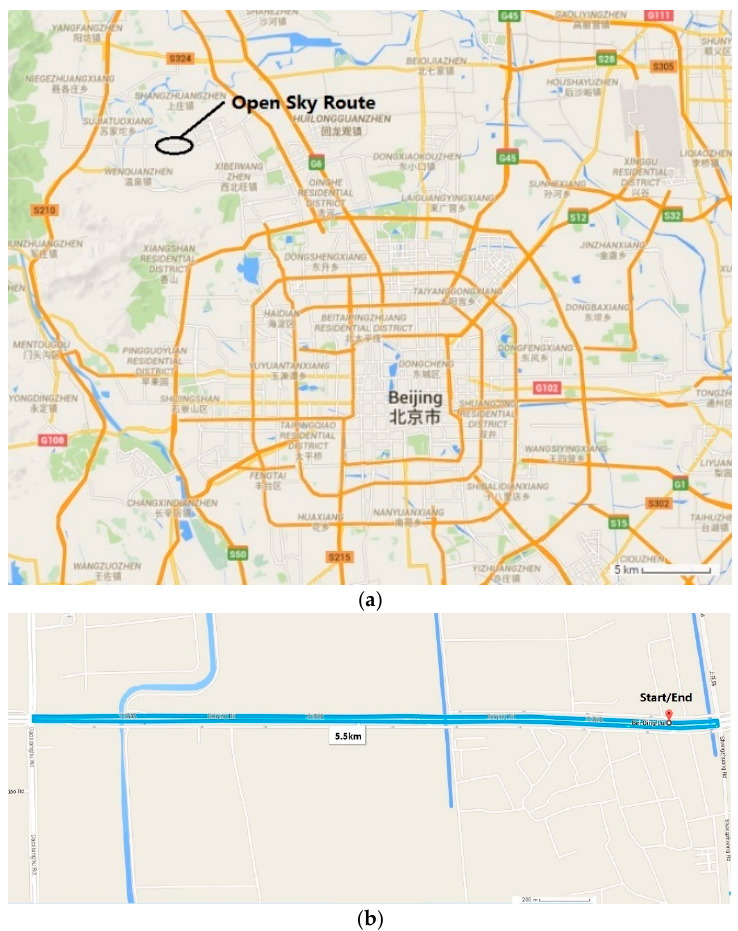
Figure 6. Map of the open-sky route ( a ) Schematic map; ( b ) Detail map.